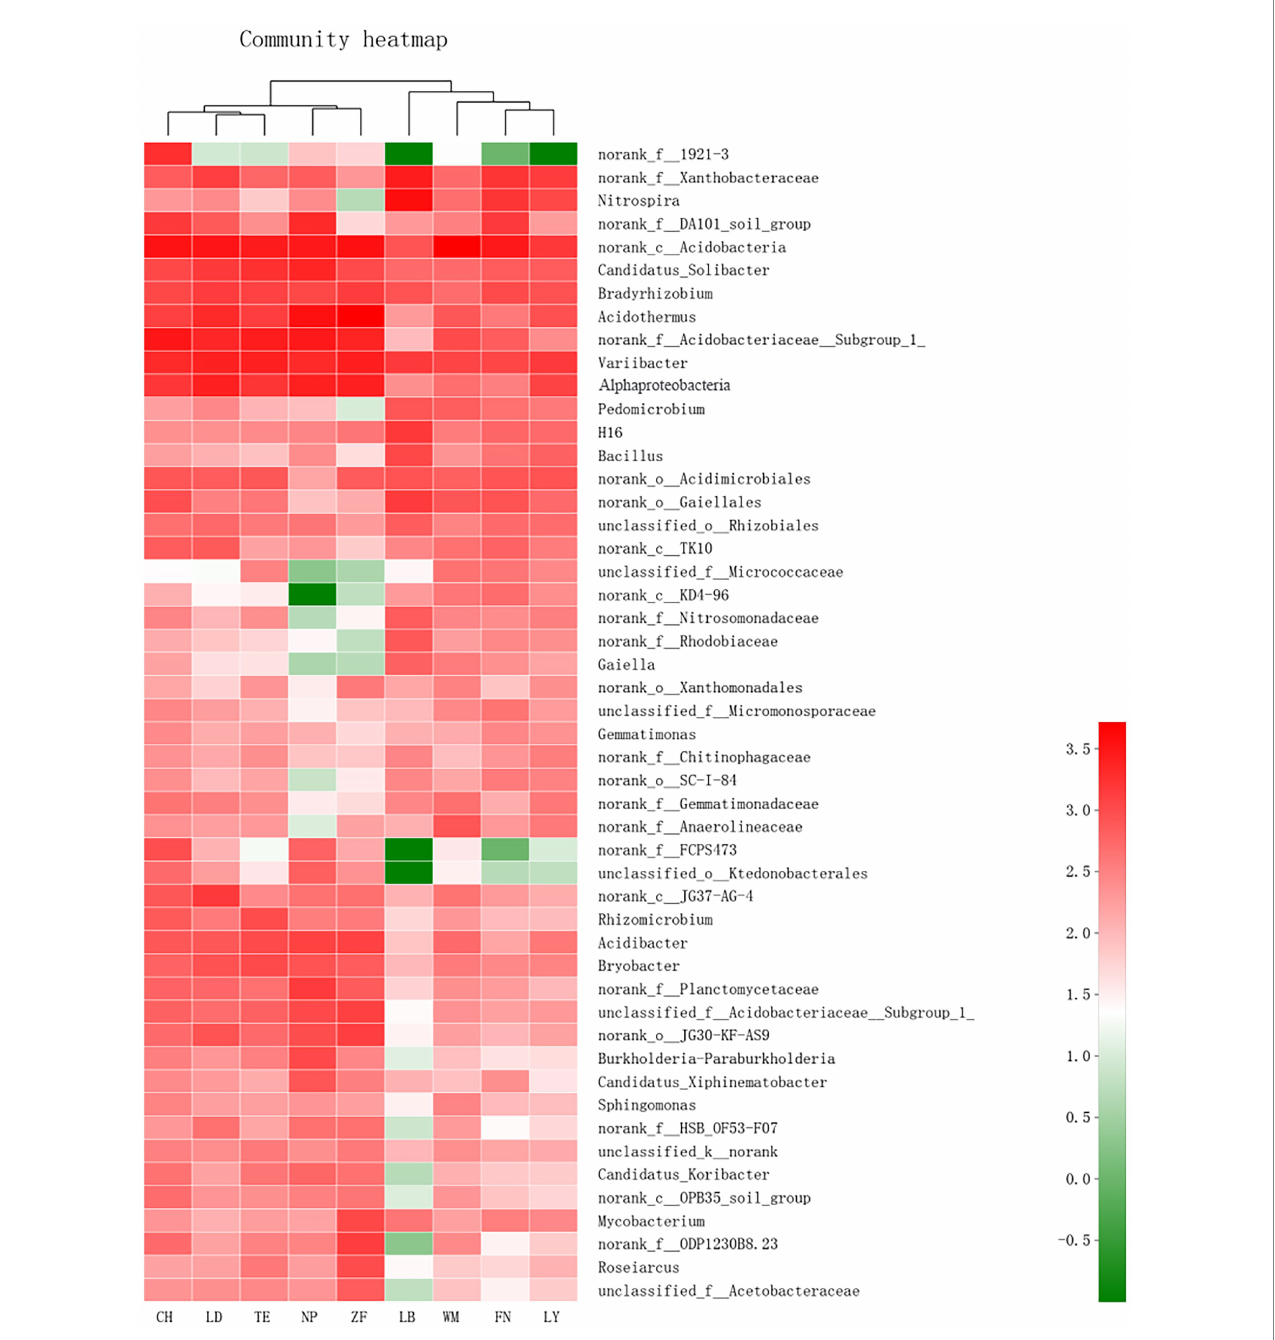
FIGURE 3 Heatmap of Bacteria in Rhizosphere Soil of C. migao. Heatmap of the top 50 most abundant genera in bacterial communities detected across nine sample sites. Dendrograms for hierarchical cluster analysis and sample locations were shown at the